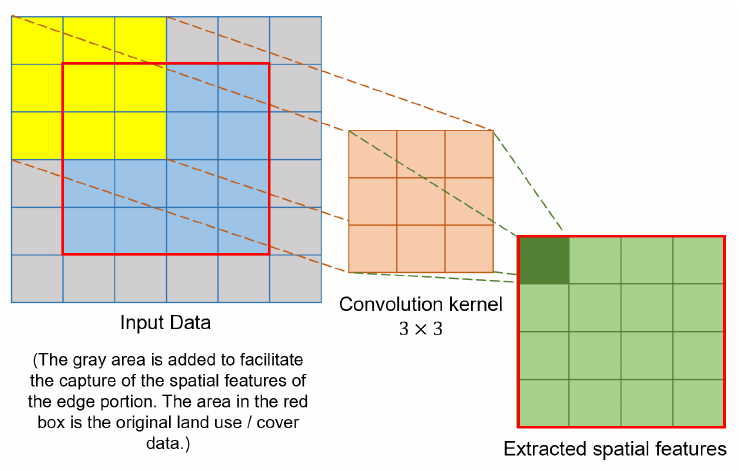
Figure 4. The process of convolution